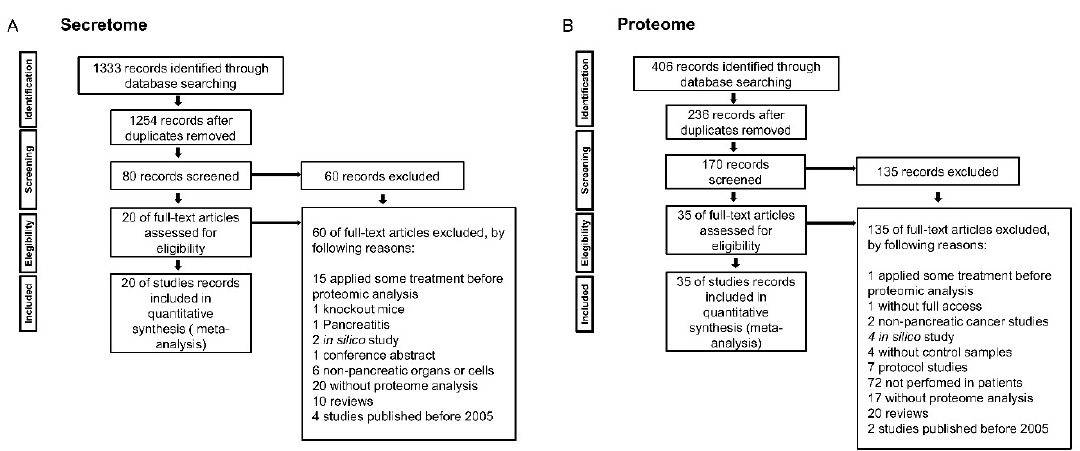
Figure 1. Flowchart of the integrative secretome ( A ) and proteome ( B ) meta-analyses in pancreatic cancer. Table 1. Description of publicly available proteomic studies used in the secretome meta-analysis. Ref.